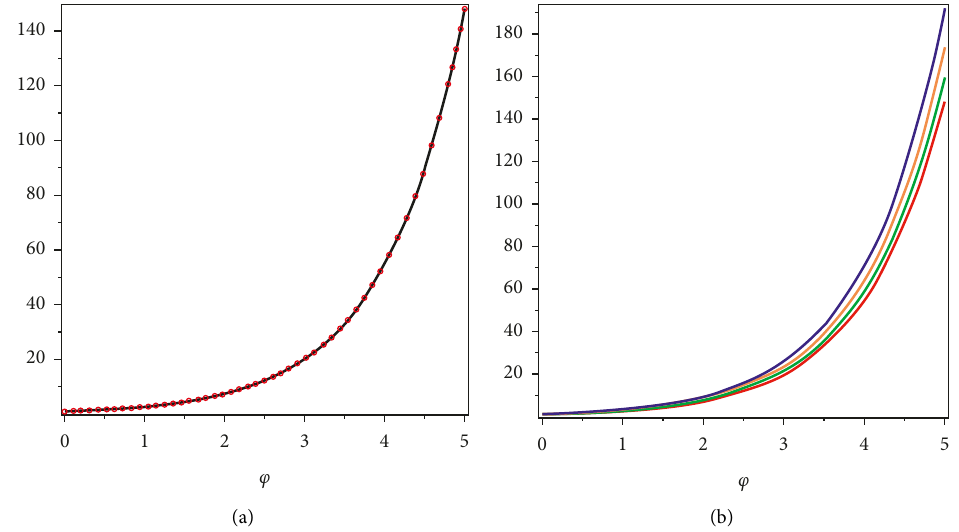
Figure 10: (a) The exact and approximate solution at δ � 1 and (b) the different fractional order of δ